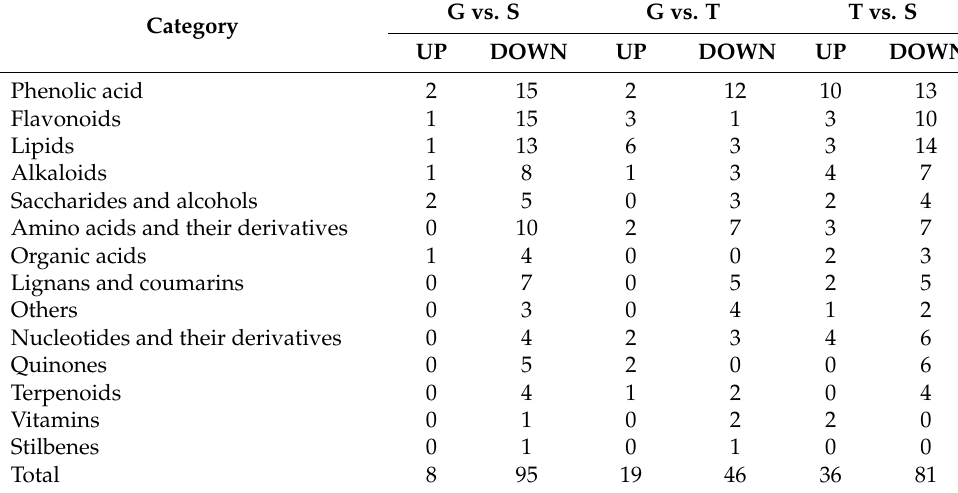
Table 1. Classification of the different